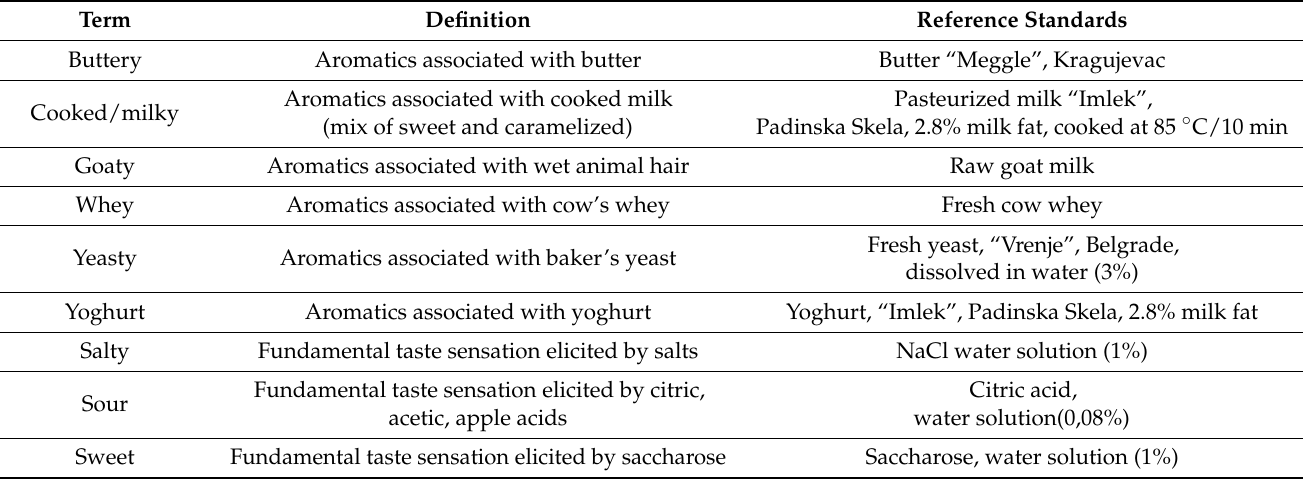
Table 2. Goat cheese taste attributes and reference